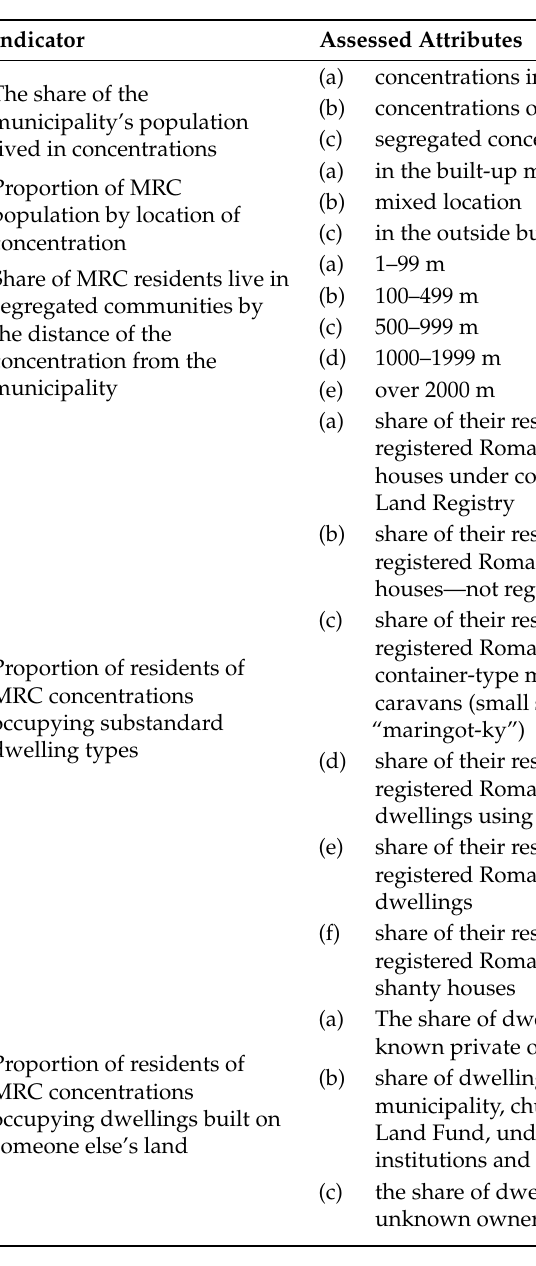
Table 1. The sets of indicators used to calculate the MRC segregation index in the municipalities of the Central Spiš